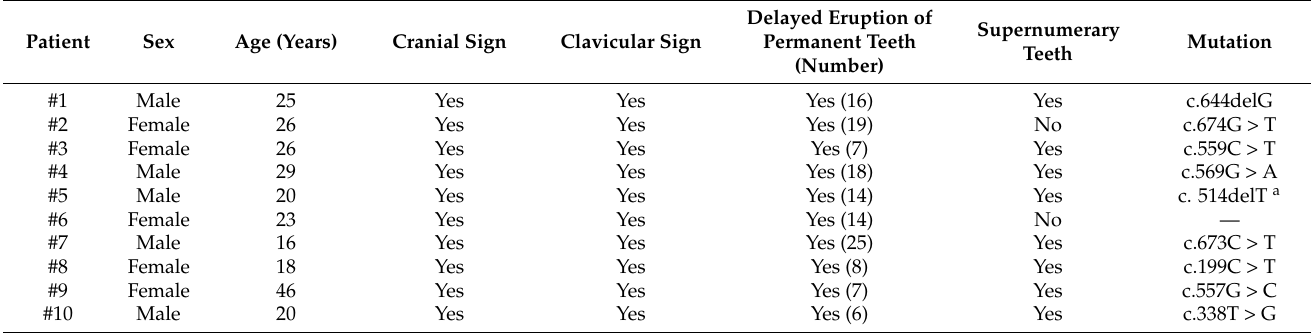
Table 1. Clinical features of 10 CCD